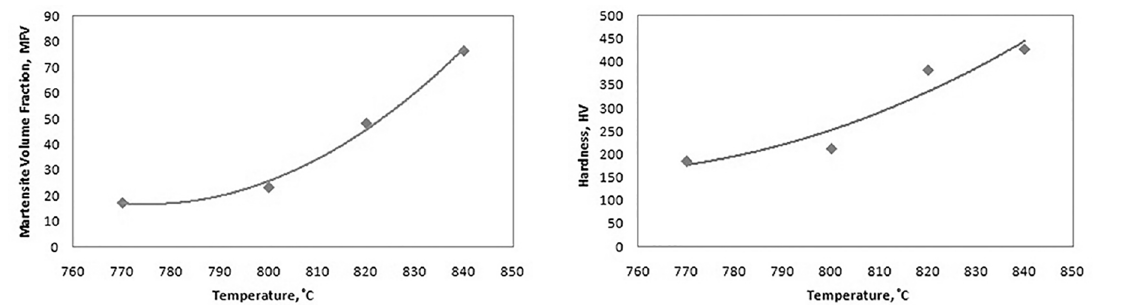
Figure 3. The variation of martensite volume fraction (MVF) as a function of intercritical temperature.